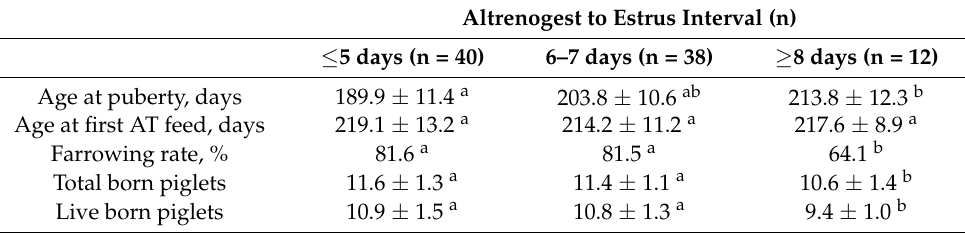
Table 3. Influence of interval from AT withdrawal to estrus on gilt performance (mean ±